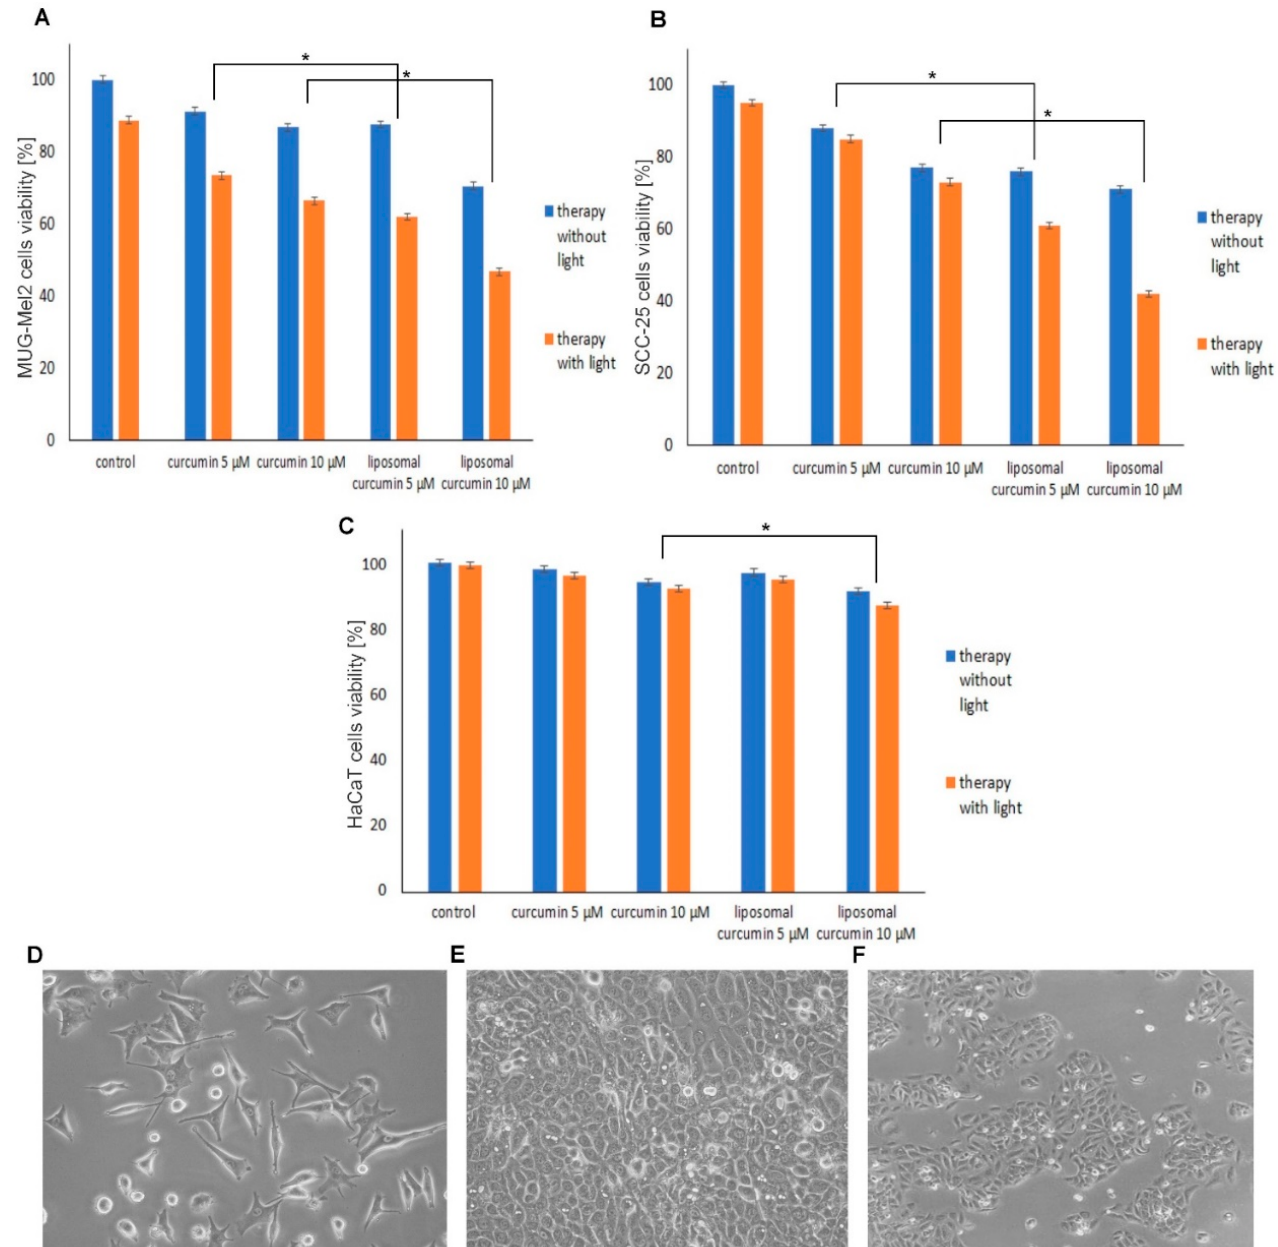
Figure 2. Results of cell viability after 4 h of incubation with 5, 10 µ M curcumin and liposomal curcumin with and without the irradiation (2.5 J/cm 2 ) evaluated by the MTT (3-(4,5-dimethylthiazolyl-2)-2,5-diphenyltetrazolium bromide) assay. ( A ) Viability-dependent bars for MUG-Mel2 cells after incubation with curcumin and liposomal curcumin without/with light. ( B ) Viability-dependent bars for SCC-25 cells after incubation with curcumin and liposomal curcumin without/with the light. ( C ) Viability-dependent bars for HaCaT cells after incubation with curcumin and liposomal curcumin without/with light. Encapsulated curcumin is significantly more cytotoxic than free curcumin in cancer cells. ( D–F ) Representative images of MUG-Mel-2, SCC-25, HaCaT cells morphology detected by phase-contrast microscopy. Results represent the mean from three different experiments. * p < 0.05.